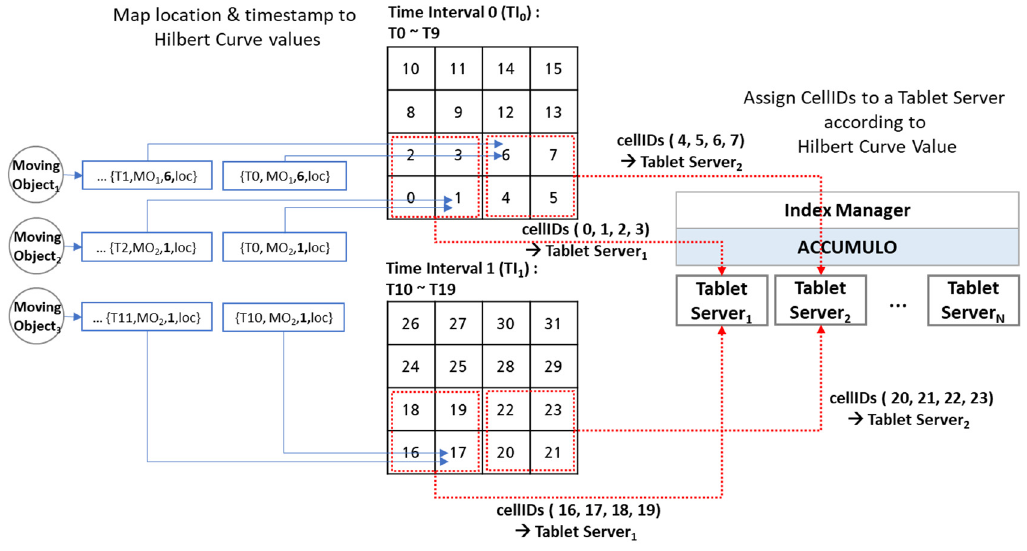
Figure 5. Proposed indexing method based on Hilbert Curve technique.